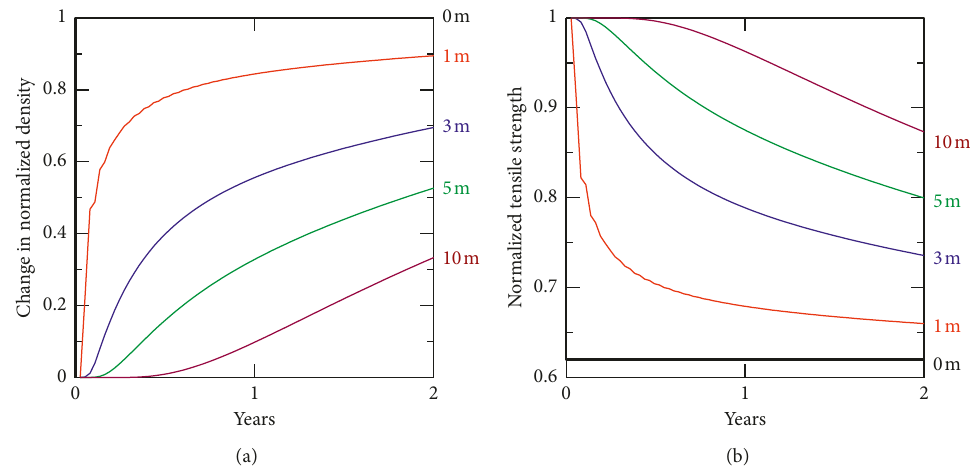
Figure 18: Response to a step humidity increase from 0 to 100%. (a) Delayed migration of density change. (b) Delayed weakening of roof rocks.